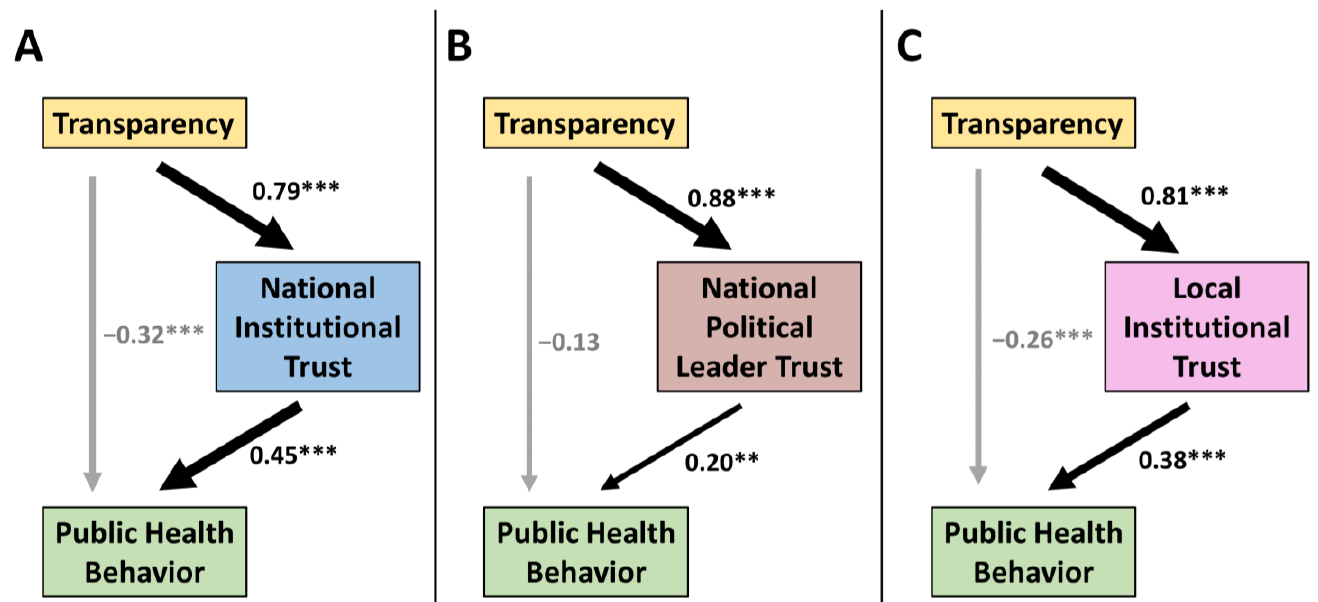
Figure 3. Exploration of causal effects of transparency on different components of government trust. Summary of the three government trust structural equation models tested to explore the causal effects of transparency on public health behavior: ( A ) national institutional trust, ( B ) national political leader trust, and ( C ) local institutional trust. Standardized coefficients and their significance are reported for each pathway (* p < 0.05; ** p < 0.01; *** p < 0.001). The p values in ( A ) and ( C ) are all less than 0.001. In ( B ), the p value for the − 0.13 coefficient is 0.060, for the 0.20 coefficient is 0.003, and for the 0.88 coefficient is less than 0.001. The RMSEA for each model is ( A ) 0.074, ( B ) 0.064, and ( C ) 0.058 (with all models having an RMSEA upper bound <0.08 in their confidence intervals), and the CFI for each model was ( A ) 0.961, ( B ) 0.971, and ( C ) 0.972. Thus, both RMSEA and CFI each indicate a high-quality fit for all three models.